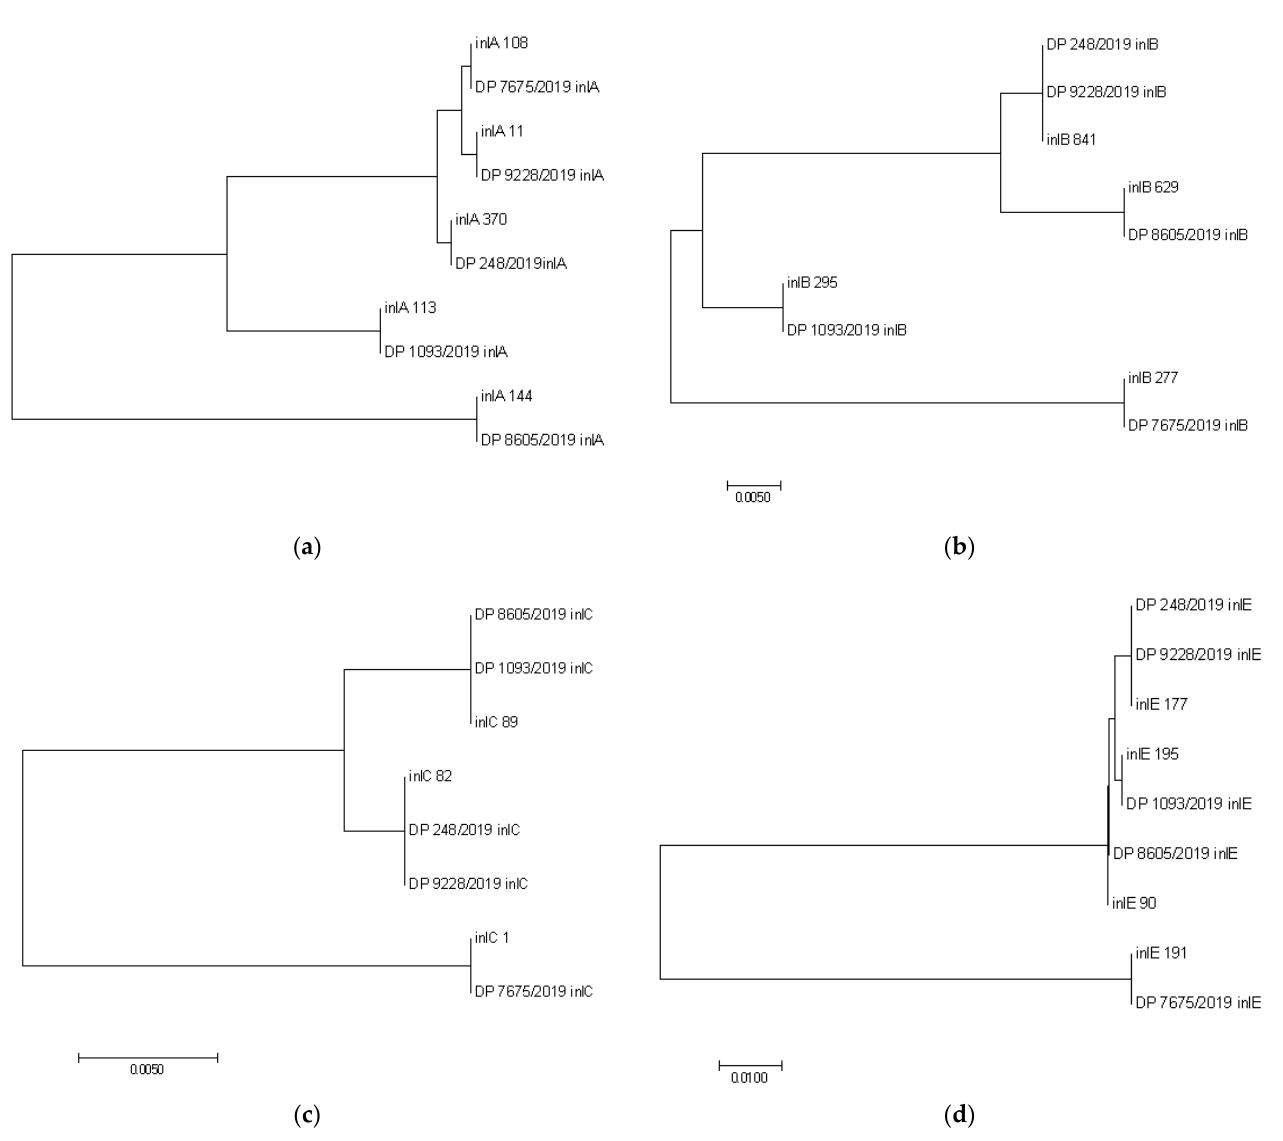
Figure 6. Phylogenetic analysis of the interanalins inlA , inlB , inlC, and inlE genes of the L. monocytogenes strains isolated in the Republic of Serbia in 2019 and the reference sequences of allelic profiles from the BIGSdb-Pasteur MLST database https://bigsdb.pasteur.fr/listeria/listeria.html). ( a – d ) Phylogenetic tree was created in MEGA 7 [30] using the maximum likelihood method with 100% bootstrap support.